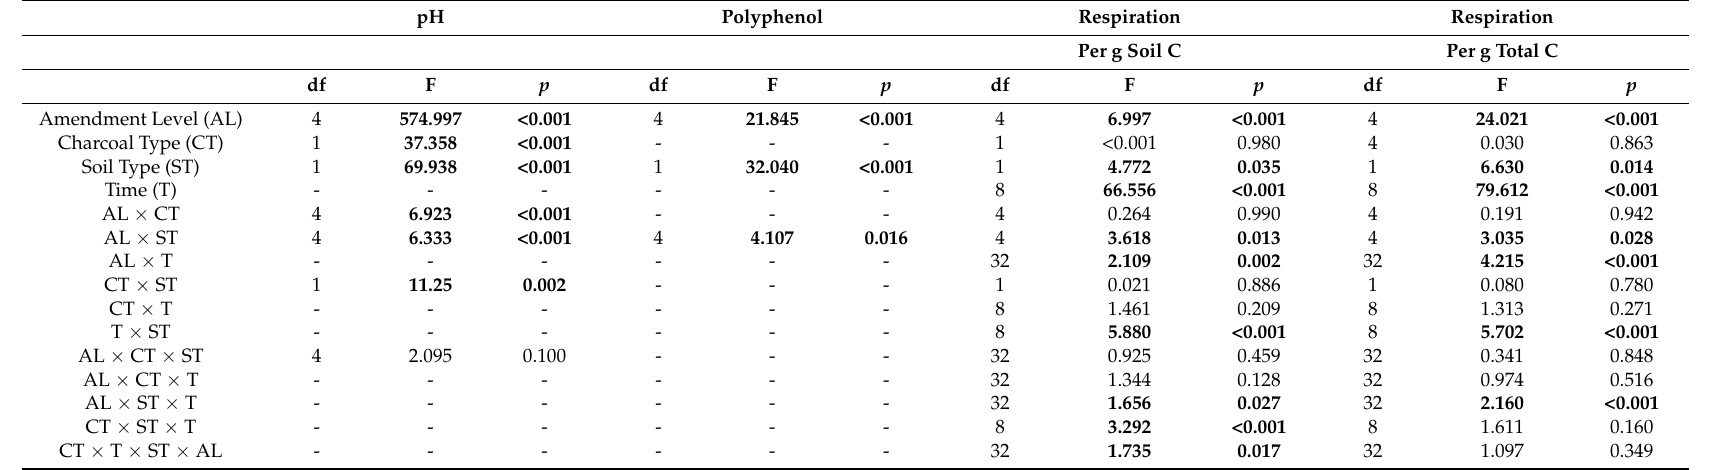
Table 2. Results from the ANOVA (degrees of freedom, df; F-values, F; and probabilities, p ) for pH, polyphenol sorption, and respiration expressed per g soil C or total C (soil C plus charcoal C). Significant F and p values are highlighted in